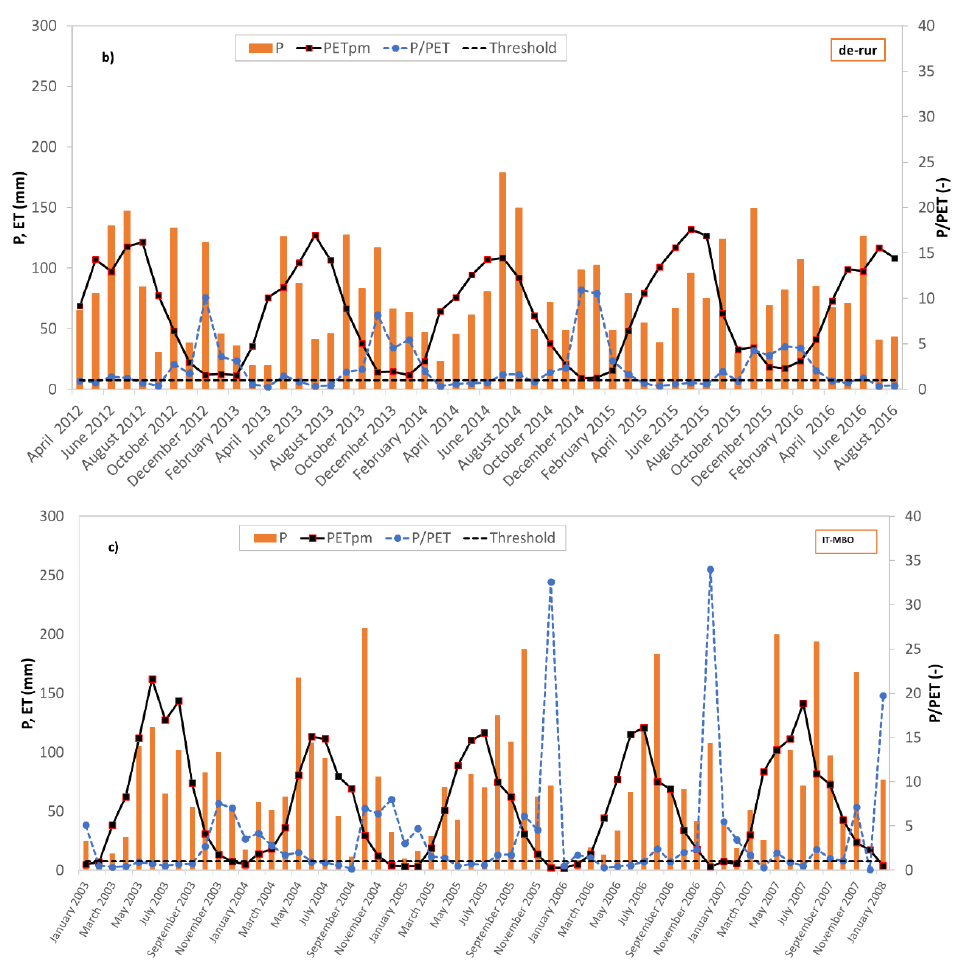
Figure 2. Monthly rainfall, Penman potential evapotranspiration and Budyko Index I = P/PET at Sister site ( a ), Rollesbroich site ( b ) and Bondone Mountain ( c ) for the period under investigation. The threshold of Rn has been set at 2 MJ/m 2 d −1 .